Question: Provide a one-line summary of what is displayed.
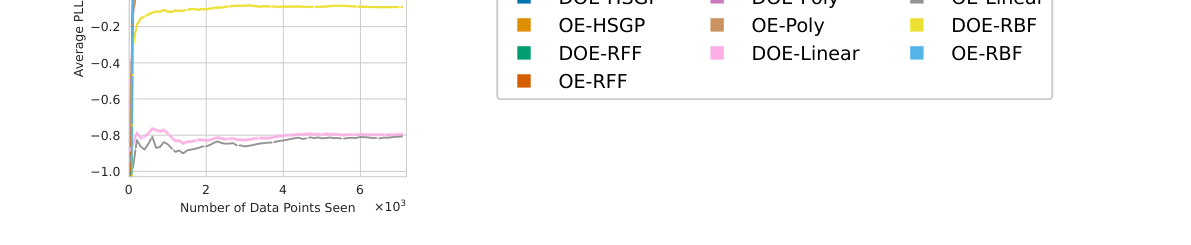
Answer: PLL plots of each method tested in the experiment of Section 5.1. Lines indicate the mean over 10 trials, with shaded regions denoting ±1 standard deviation.